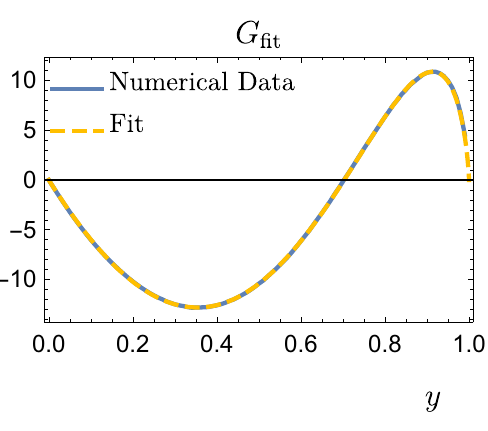
Figure 5 . Fit function G (cid:12)t (dashed orange line) as given in eq. (3.16) compared to the (interpolated) numerical data from pySecDec (solid blue line). The numerical uncertainties are too small to be visible in the